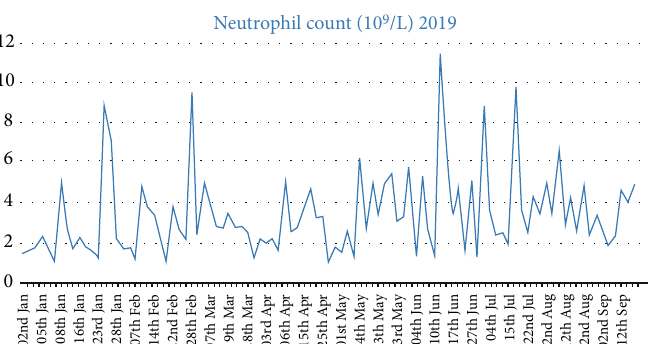
Figure 2: Neutrophil serum level from 2nd of January to 20th of September 2019. Figure 2 displays the neutrophil level by serum testing from 2nd January to 20th September 2019. The x axis demonstrates dates of sampling, and the y axis corresponds with the absolute neutrophil count × 10 9 /L. Commencement of the fi lgrastim treatment protocol in March 2019 corresponds with a period of stability in baseline ANC with fewer episodes of neutropenia. Initially, hematology supported use of fi lgrastim if red light monitoring result was received. This protocol developed to include use of fi lgrastim given an amber light result and ultimately biweekly prophylactic use of fi lgrastim to avoid a red light